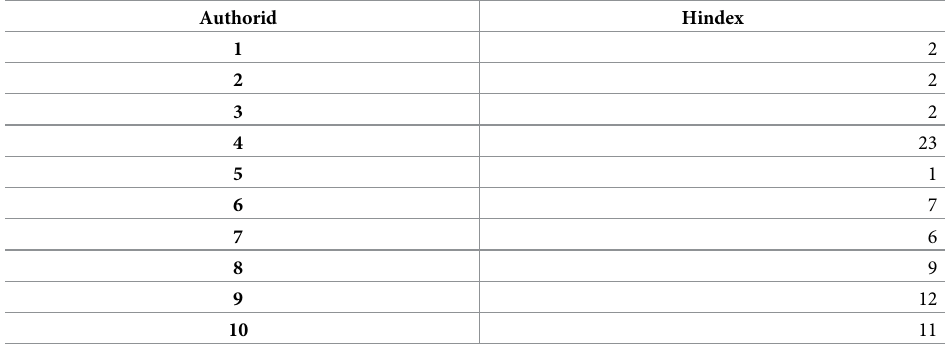
Table 8. h-index of all authors (Table